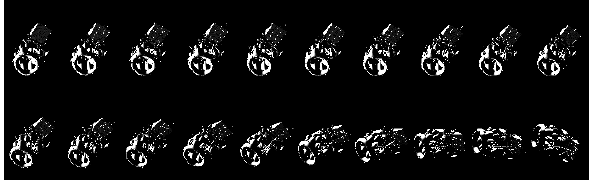
Figure 7. Sequence of AES images upon its motion along the real orbit